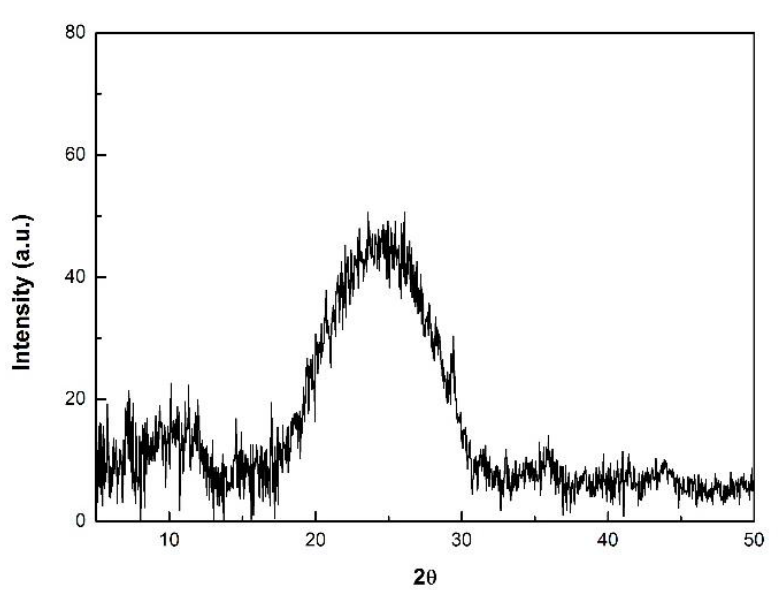
Figure 11. XRD diffraction patterns of the POA sample.